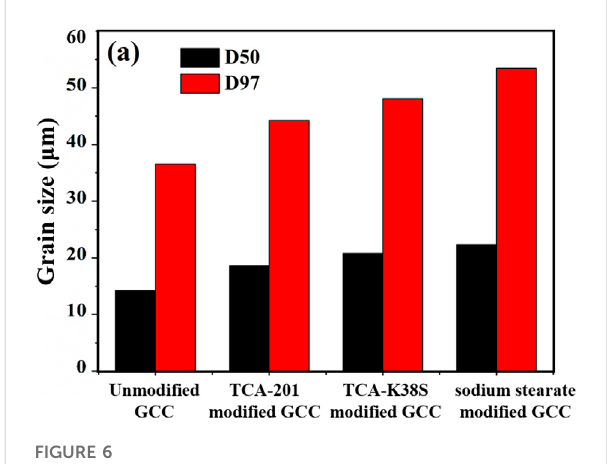
FIGURE 6 Particle size change of GCC after modi fi